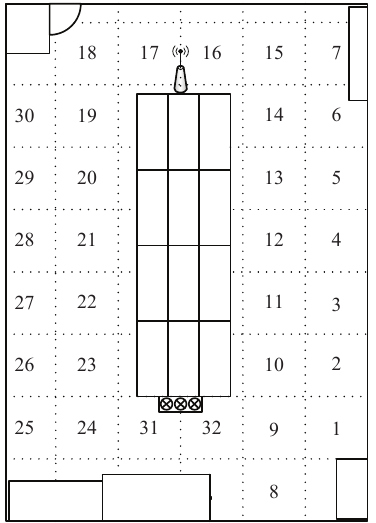
Figure 6. The layout of the experimental scene.